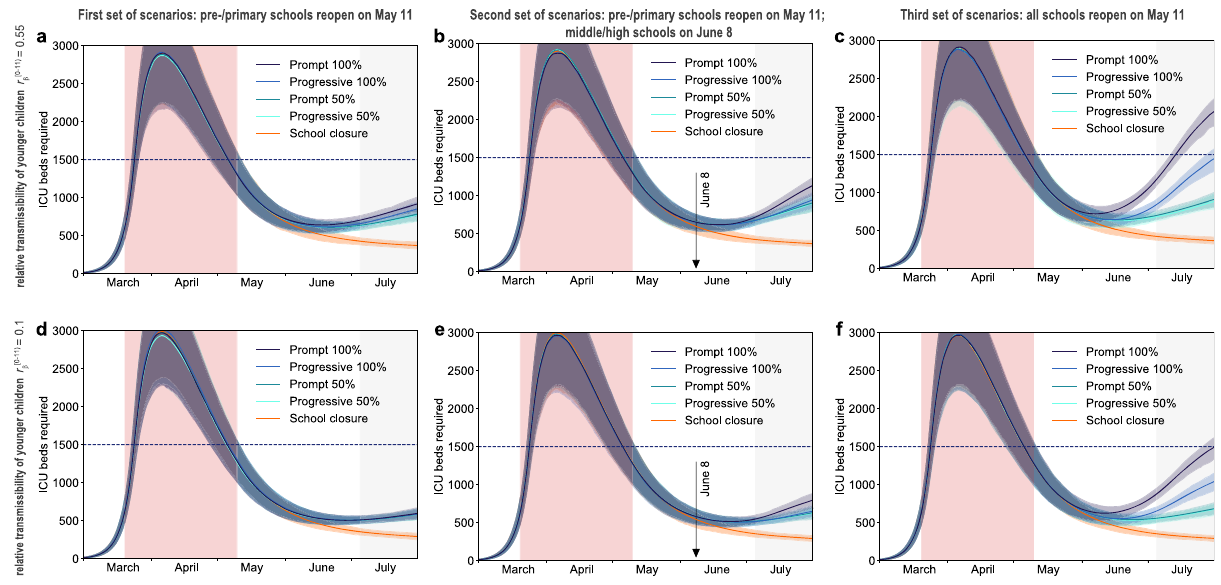
Fig. 5 Simulated ICU occupancy in scenarios with reopening of schools. a – c Simulated demand of ICU beds assuming that only pre-schools and primary schools are reopened on May 11 through 4 different protocols ( fi rst set of scenarios, panel a ), additionally considering the reopening of middle and high schools on June 8 (second set of scenarios, panel b), or assuming that all school levels reopen on May 11 (third set of scenarios, panel c ). Four protocols ( Progressive (100%, 50%), Prompt (100%, 50%) ) are compared to the school closure scenario. Curves and shaded areas correspond to median and 95% probability ranges, obtained from n = 500 independent stochastic runs. Results are obtained for a relative transmissibility of younger children r ½ 0 (cid:2) 11 Þ β ¼ 0.55,